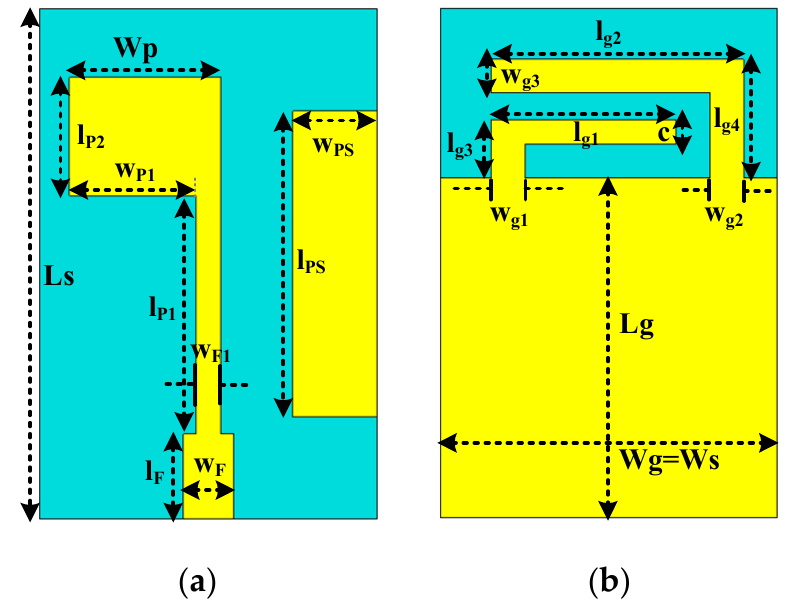
Figure 1. ( a ) Antenna front dimensions. ( b ) Antenna back dimensions.